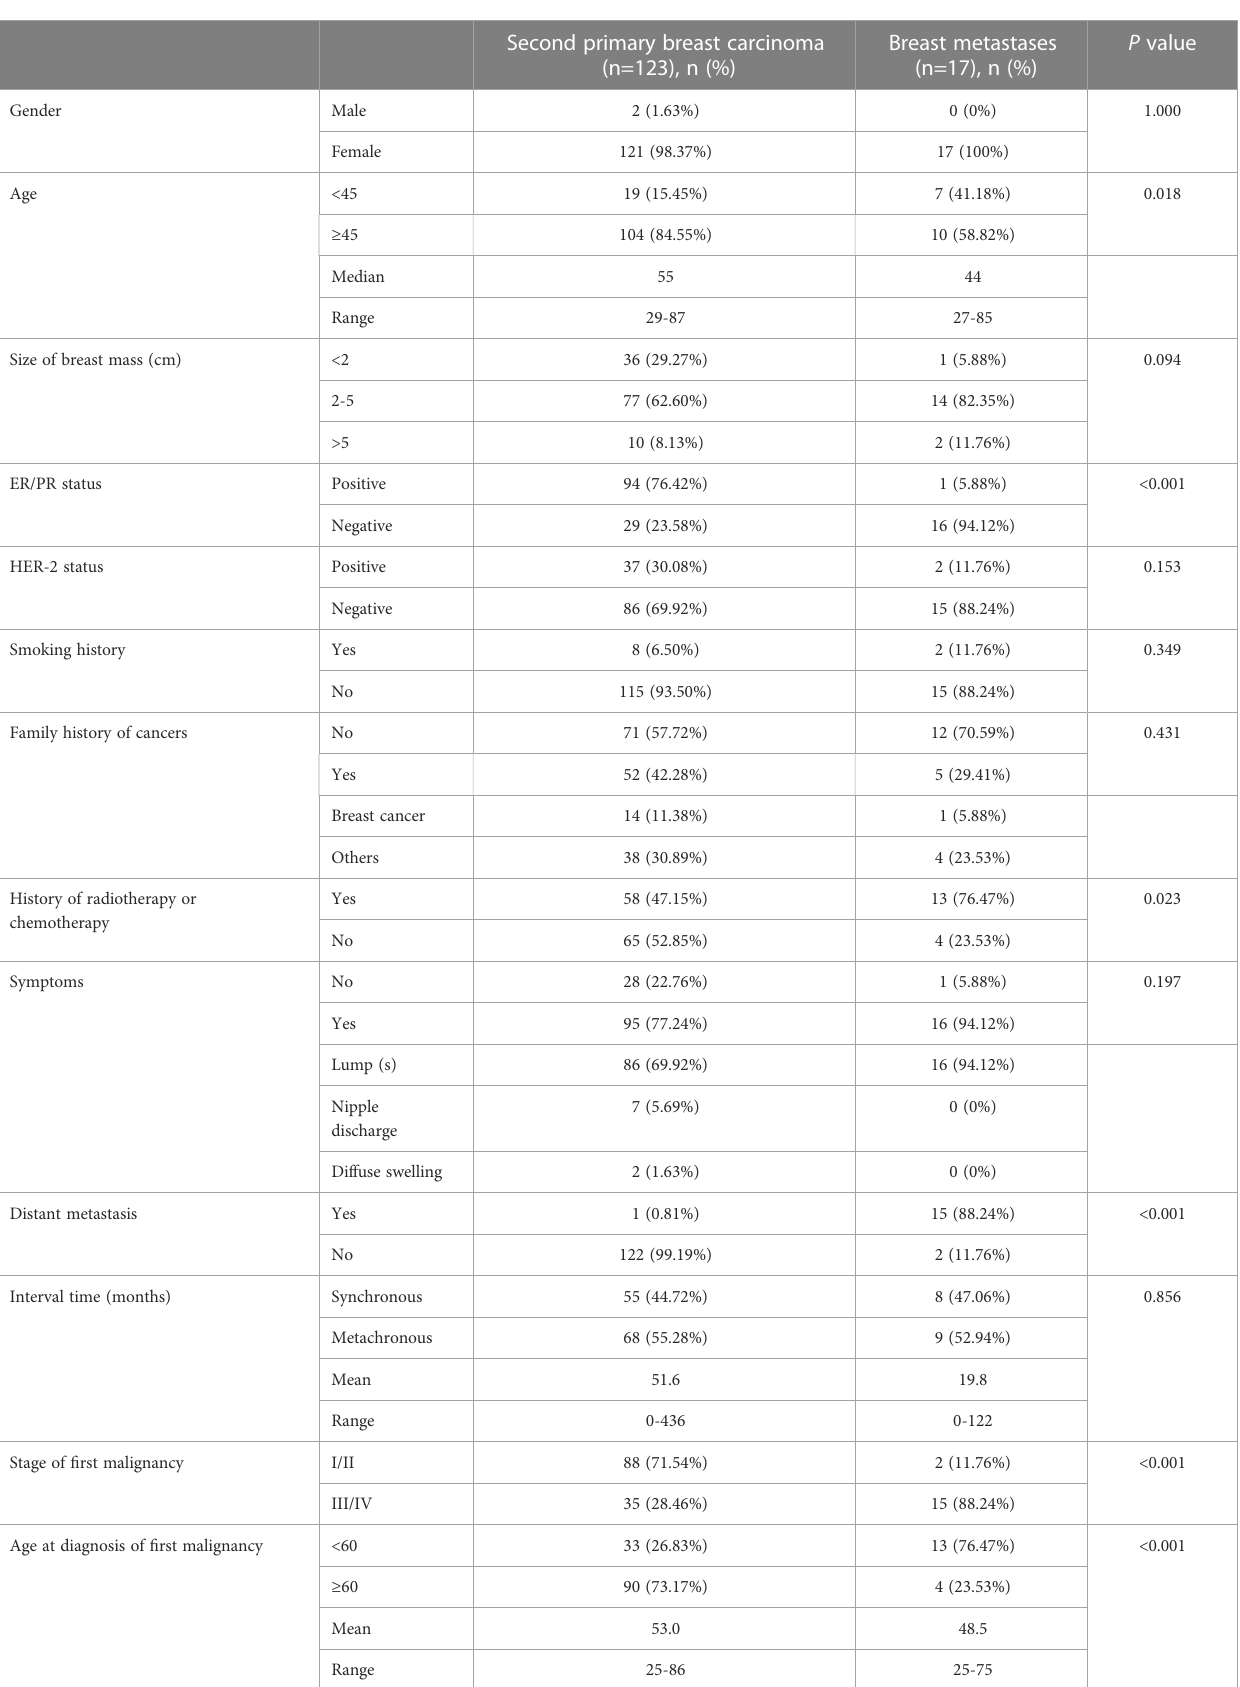
TABLE 1 Clinical characteristics of patients with second primary breast carcinoma and with those of breast